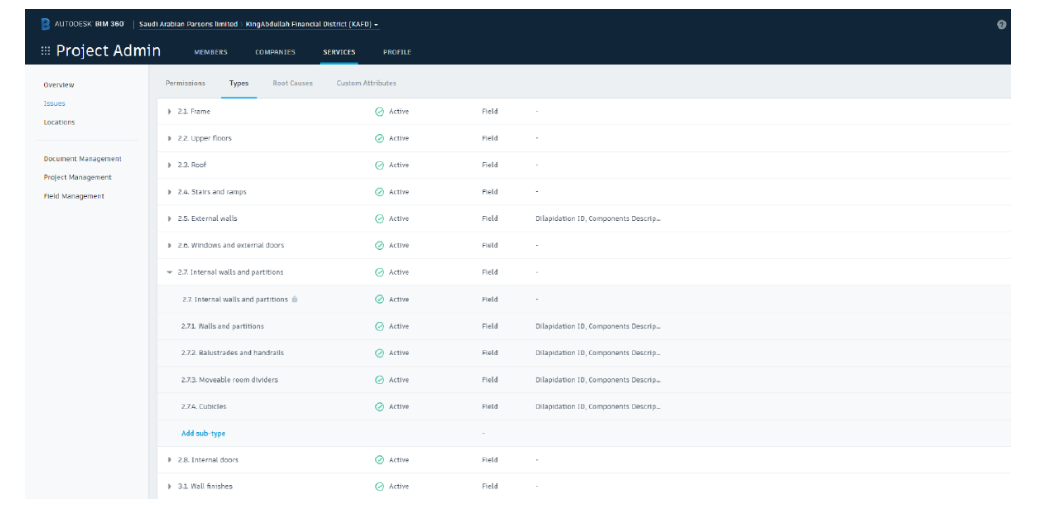
Figure 9: Issue Types & Sub-types in BIM 360 BUILD